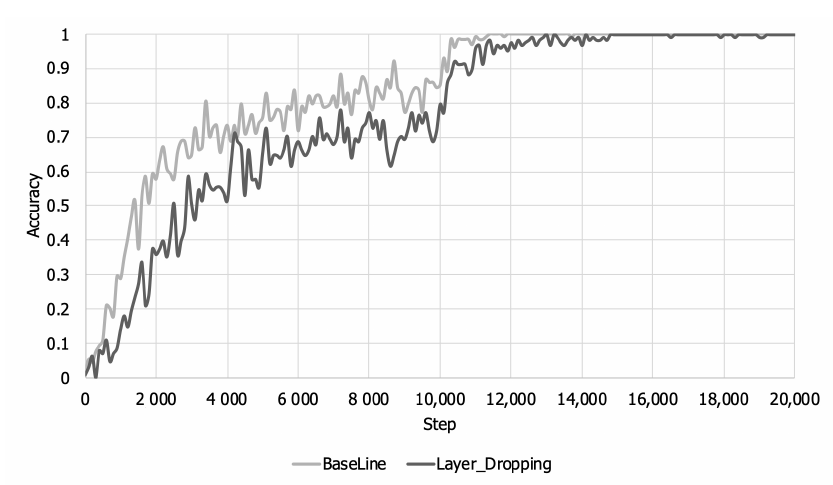
Figure 5. Training loss per step in a low bandwidth network.